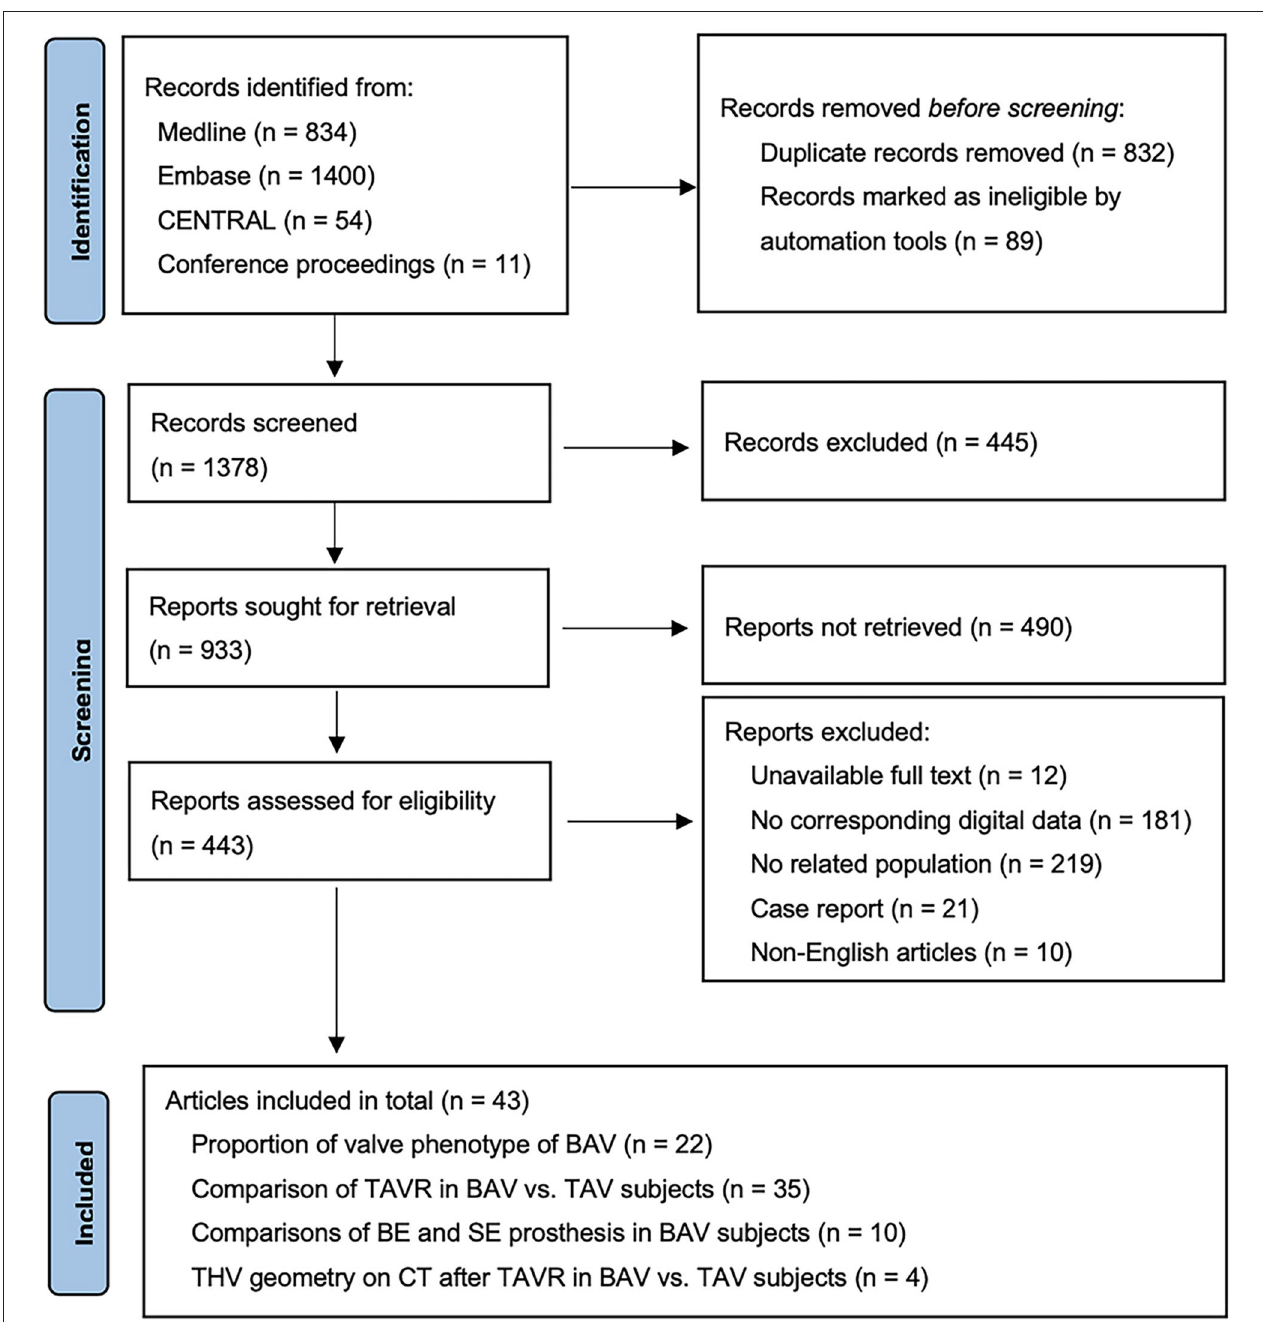
FIGURE 1 | Preferred Reporting Items for Systematic Reviews and Meta-Analyses (PRISMA) 2020 flow